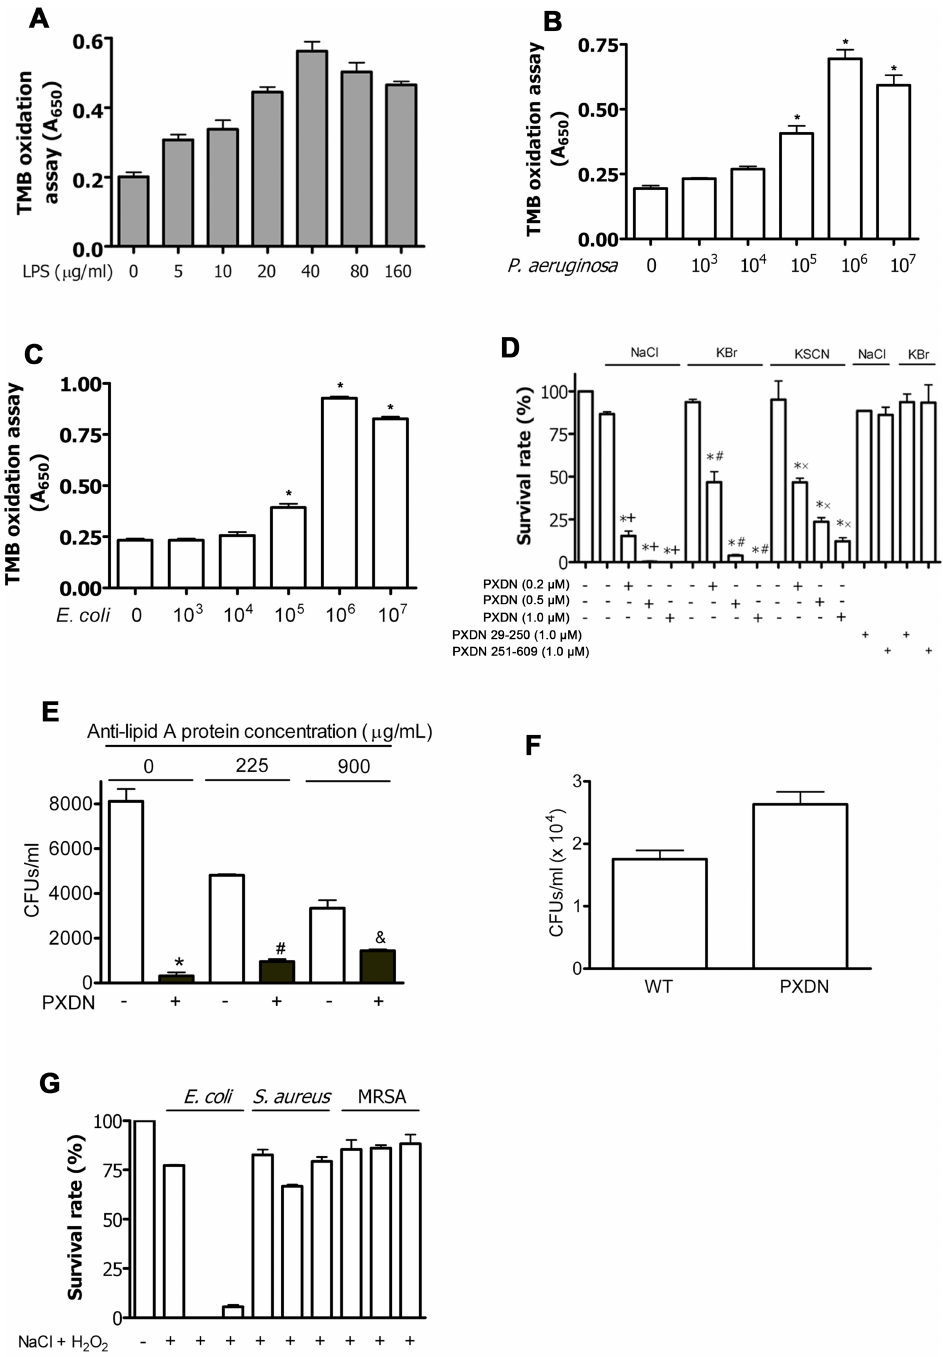
Fig 3. PXDN selectively kills GN bacteria in vitro .(A) LPS stimulates PXDN activity. Reaction mixtures (100 μL each) containing TMB solution, H 2 O 2 , recombinant FL-PXDN (400 nM/heme) and LPS as indicated were carried out at room temperature for 30 min. LPS and recombinant FL-PXDN were pre-incubated at 4˚C for 30 min prior to mix with TMB solution. TMB oxidation was recorded at absorbance 650 nm. One-way analysis of variance, P < 0.001 for all comparisons. (B) Live P . aeruginosa stimulates PXDN activity. P . aeruginosa was pre-incubated with recombinant FL-PXDN at RT for 30 min in 20 mM of phosphate buffer without NaCl. The mixture was added into TMB solution (100 μL) and incubated at RT for 30 min. Absorbance at 650 nm was measured. (cid:3) P < 0.05 vs . non-bacteria control. (C) E . coli stimulates PXDN activity. The same experiment was carried out as in “B” where P . aeruginosa was replaced by E